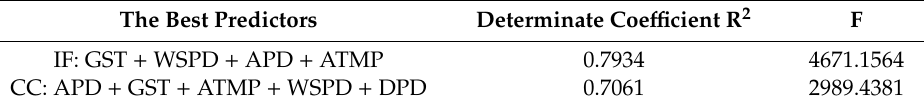
Figure 4. Importance ranking of predictors. Table 3. Results of the nonlinear regression model.